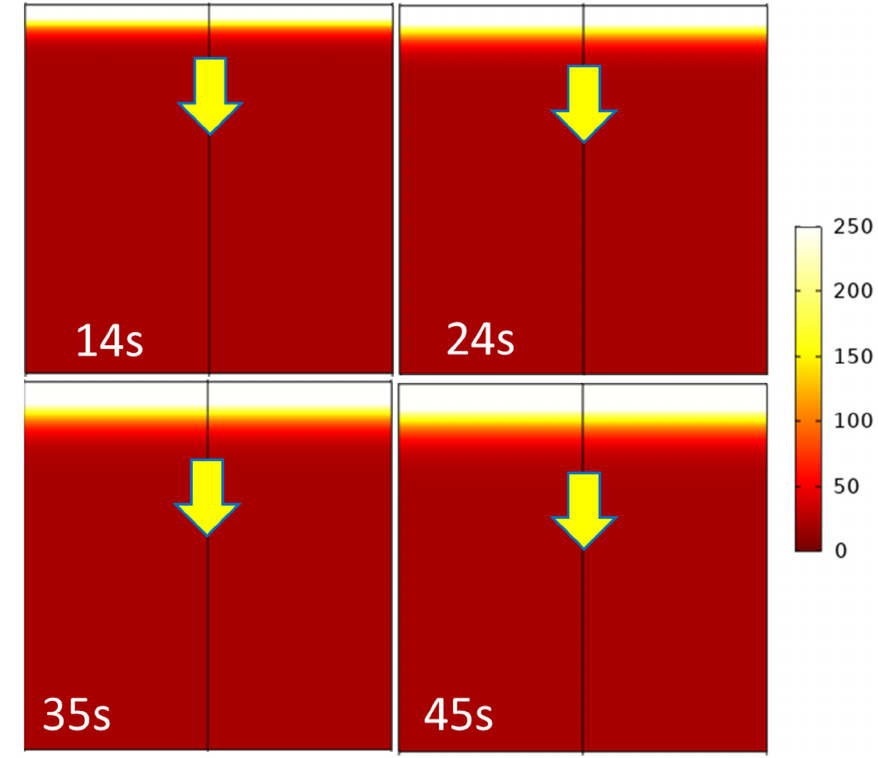
Figure 12. Simulation of the surface thermal properties in the range of 0 to 250 °C.